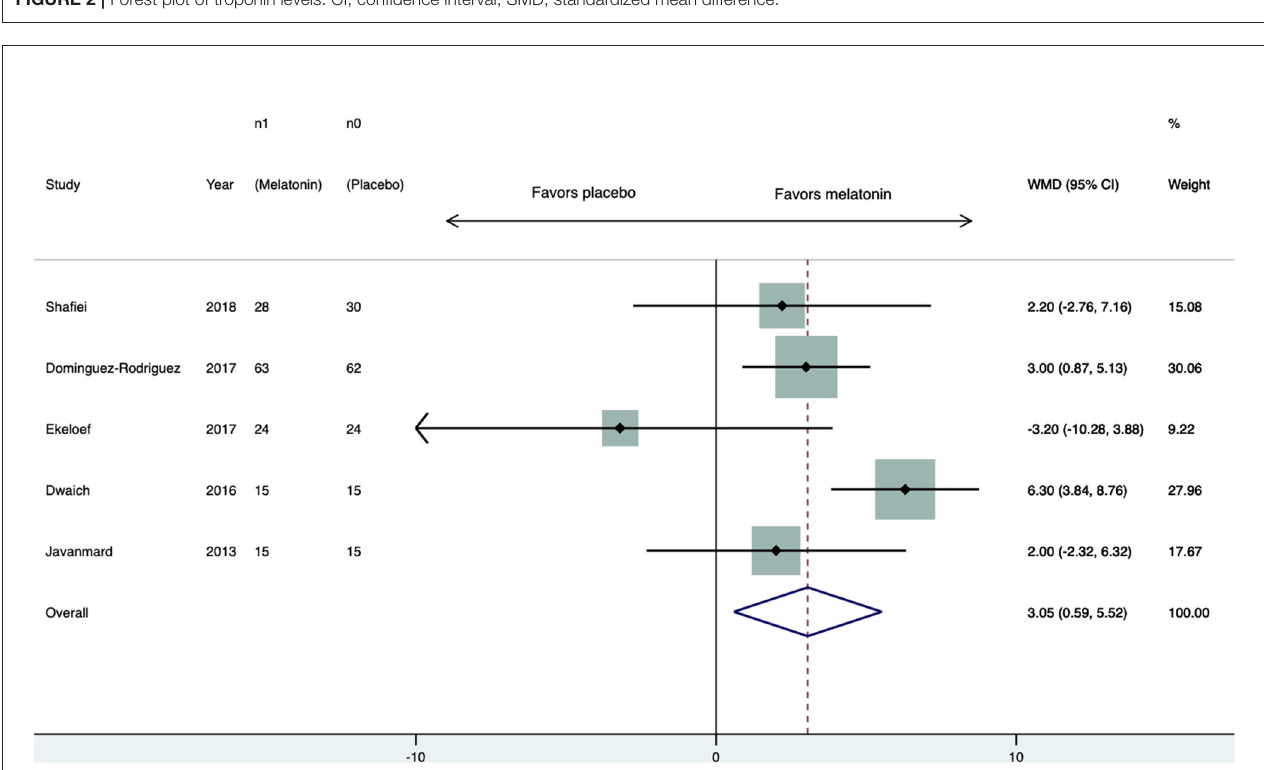
FIGURE 3 | Forest plot of LVEF. CI, confidence interval; WMD, weighted mean difference.